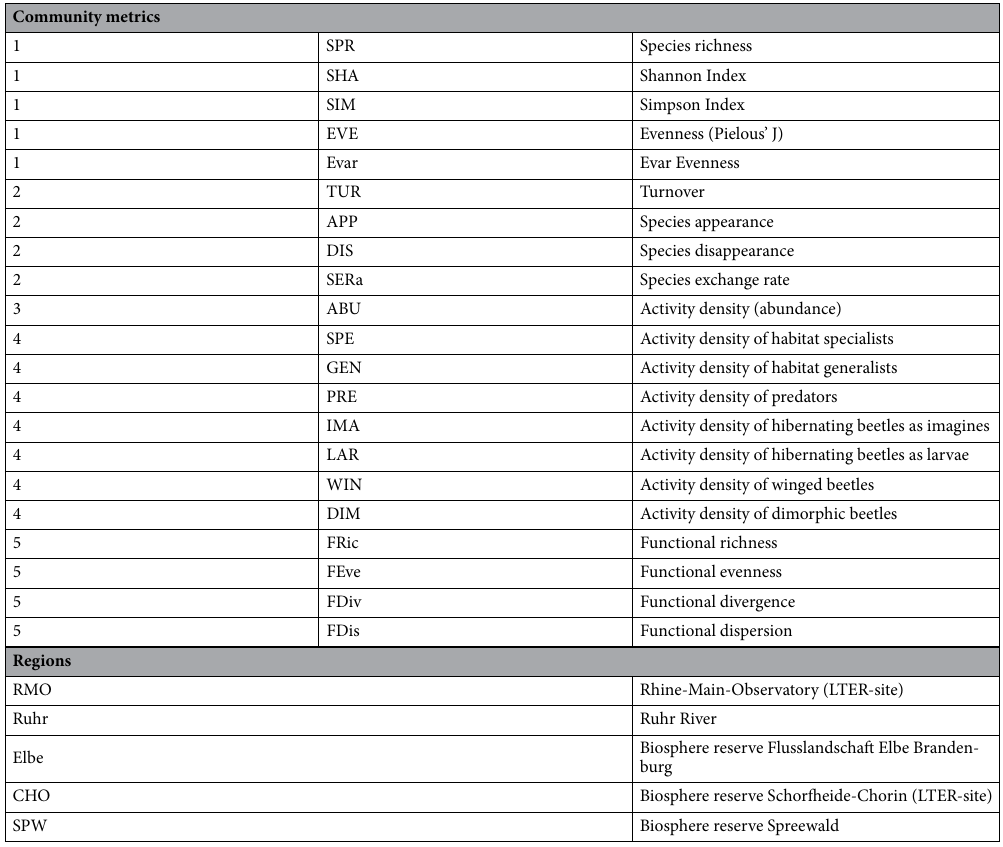
Table 1. Community metrics, regions and their abbreviations evaluated in this manuscript. 1 = taxonomic diversity, 2 = taxonomic turnover, 3 = activity density 4 = functional traits, 5 = functional